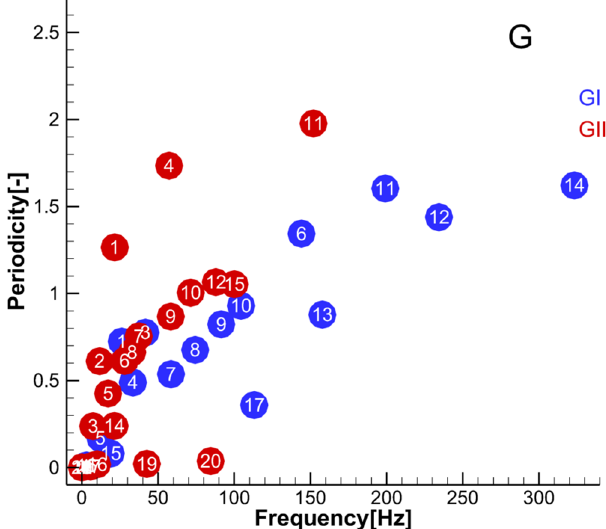
Fig. 16. OPD modes, frequency and periodicity for the branch G. Zone I in blue, zone II in